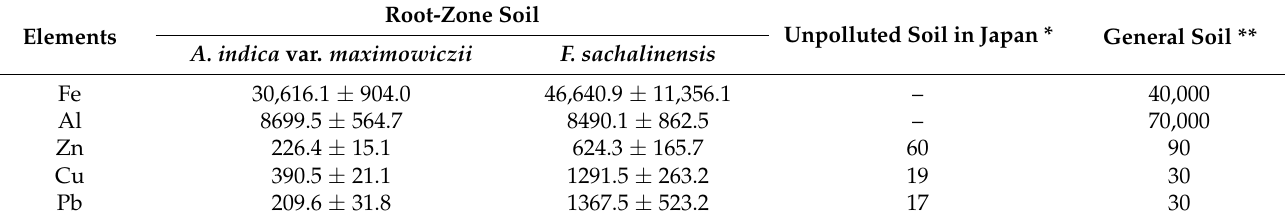
Table 2. Total element concentrations in root-zone soils of the target plants.